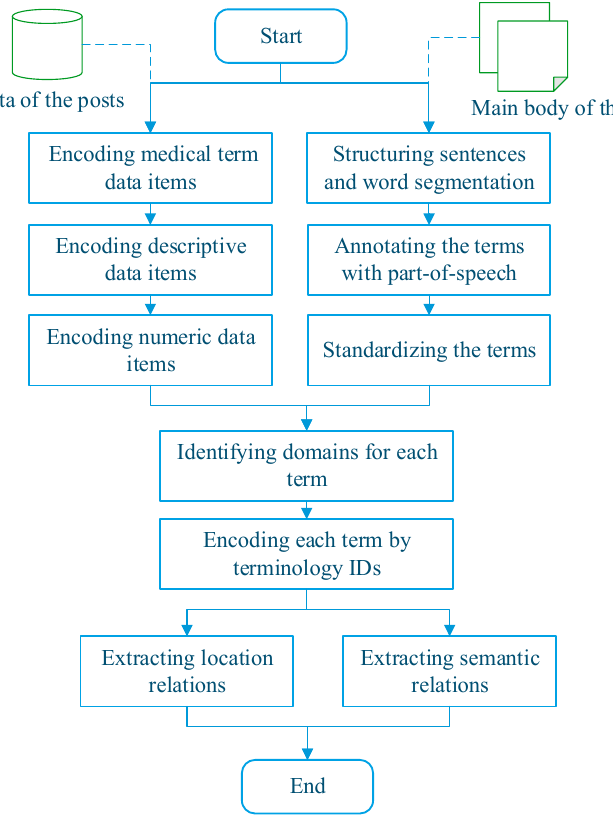
Figure 3. Flowchart of online-post analysis.